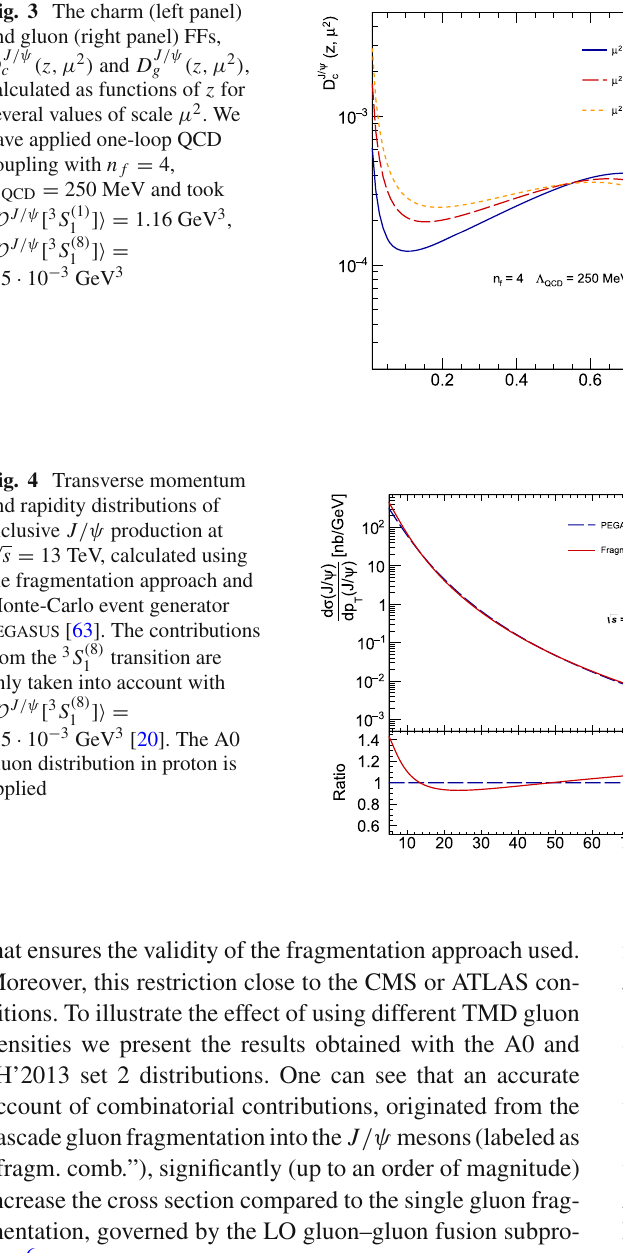
Fig. 3 The charm (left panel) and gluon (right panel) FFs, /ψ ( z ,μ 2 ) and D J /ψ ( z ,μ 2 ) , D J c g calculated as functions of z for several values of scale μ 2 . We have applied one-loop QCD coupling with n f = 4, (cid:14) = 250 MeV and took QCD